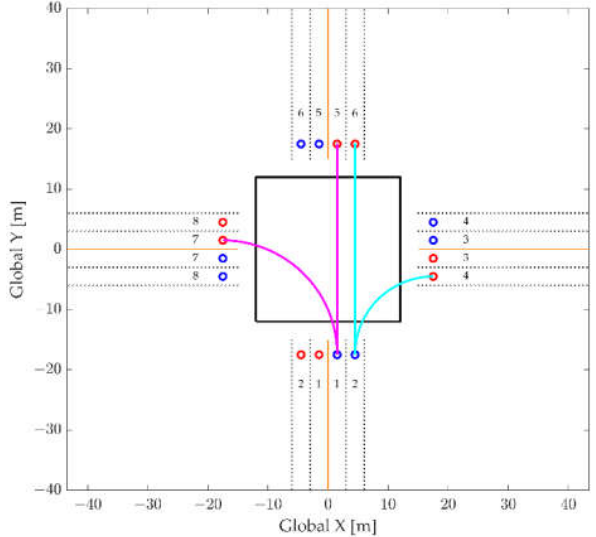
Figure 3. Example intersection for map